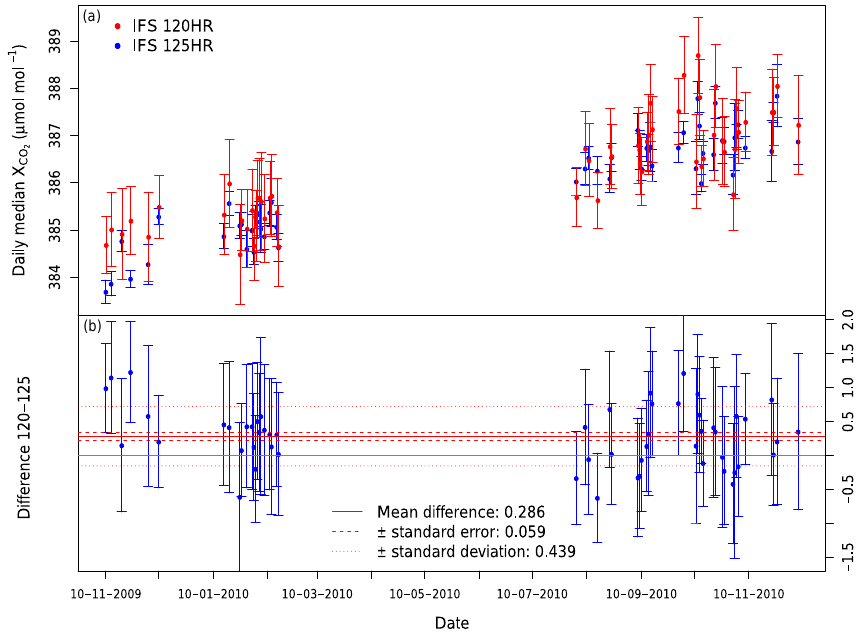
from measurements made with both FTS instruments at Lauder (a) and the difference Figure 6. Time series of daily means of retrieved X CO 2 between them (b) . Error bars in the upper panel indicate the SD about the daily mean, while those in the lower panel are the sum in quadrature of the SD about the daily means. The horizontal lines in the lower panel show the mean of the daily mean differences and the SD and standard error (SD of the sample mean) about